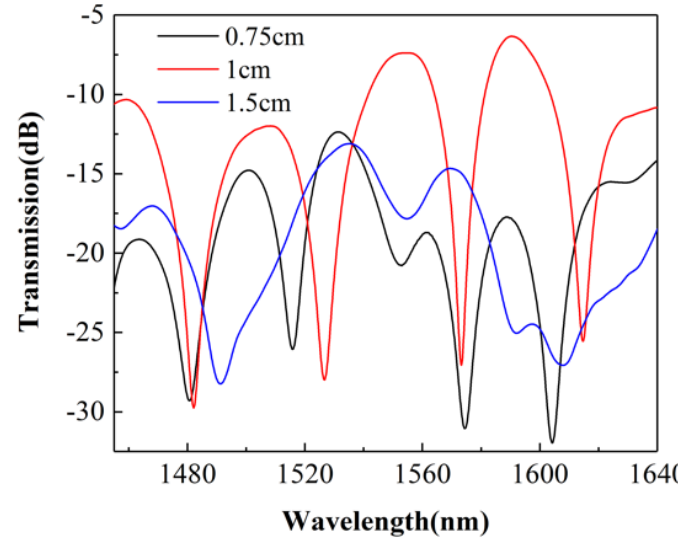
Sensors 2022 , 22 , x FOR PEER REVIEW 5 of 13 Figure 5. Transmitted spectra of the sensor with different lengths of SCSHF. Figure 6a is the simulation model of the SCSHF sensor built in the simulation soft and the simulation tool is Beam PROP. The dimension of the modeling is 3D because the structure of the SCSHF cannot be simplified. The simulation parameters are shown in the Table 2. Table 2. Simulation parameters of SCSHF sensor.